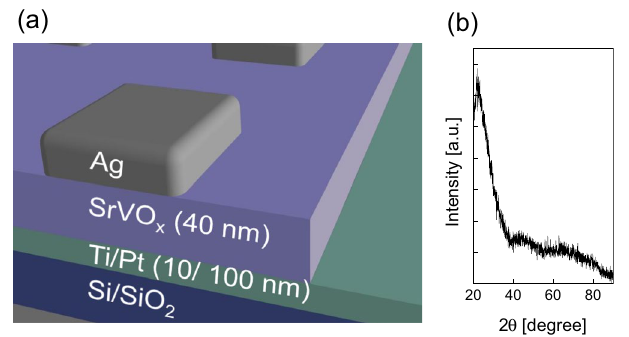
Figure 1. ( a ) 3D schematic diagram of an as-fabricated Ag/a-SVO/Pt memristor. ( b ) Typical θ -2 θ XRD pattern of a 100-nm-thick a-SVO thin film deposited on a glass substrate at room